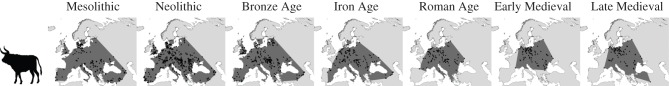
Geographical range estimates for aurochs from the Mesolithic to the Late Medieval, with range extent based on distribution of zooarchaeological records in each time period (black points).